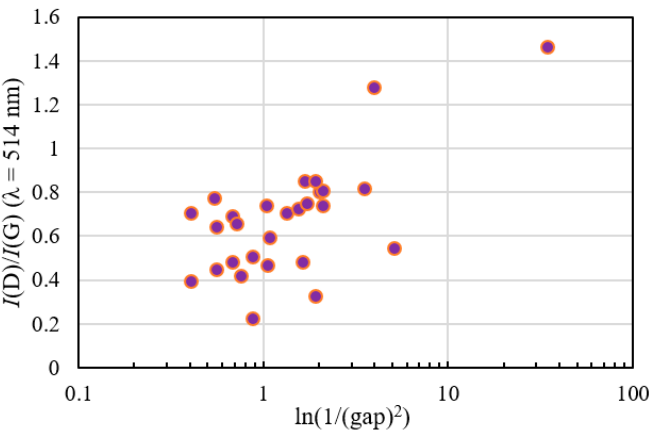
Figure 8. I (D)/ I (G) ratio of each film derived from visible Raman spectroscopic analysis vs. loga- rithm of 1/(gap) 2